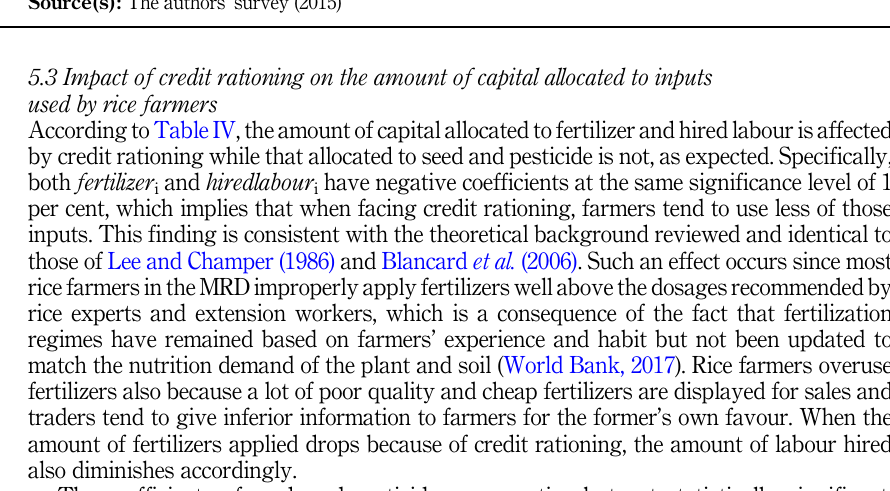
rationing facing rice farmers